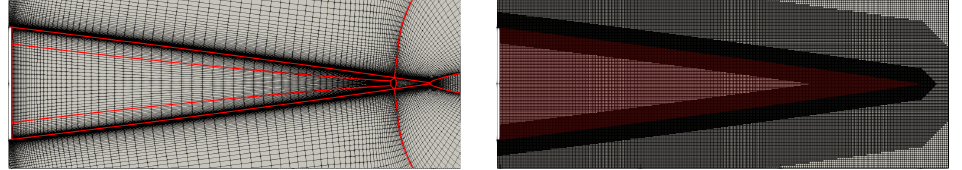
Figure 2. Detailed views of the structured RANS mesh ( left ) and the unstructured Cartesian mesh of the LES ( right ) for the porous configuration. The red shadowed area in the right figure indicates the porous